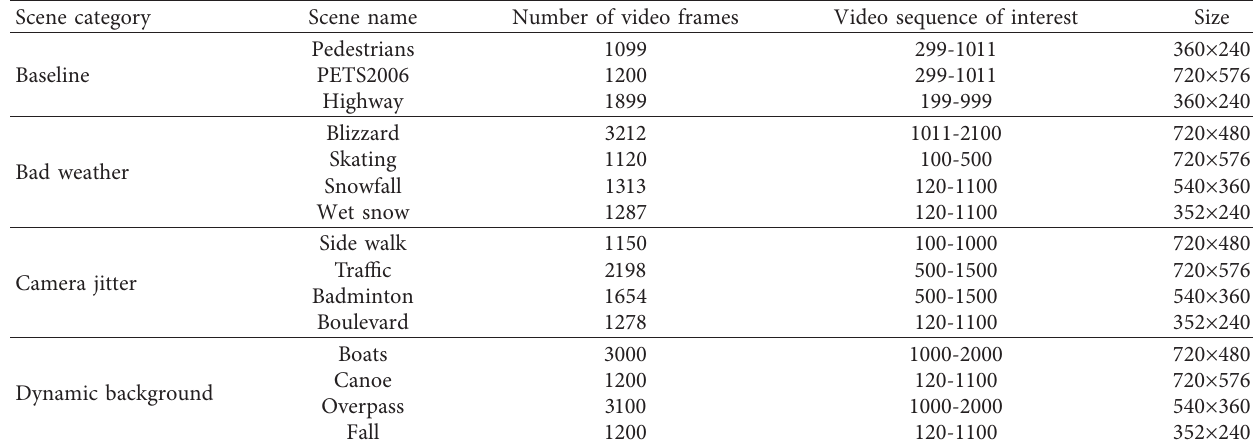
Table 2: Videos and detailed information used in the